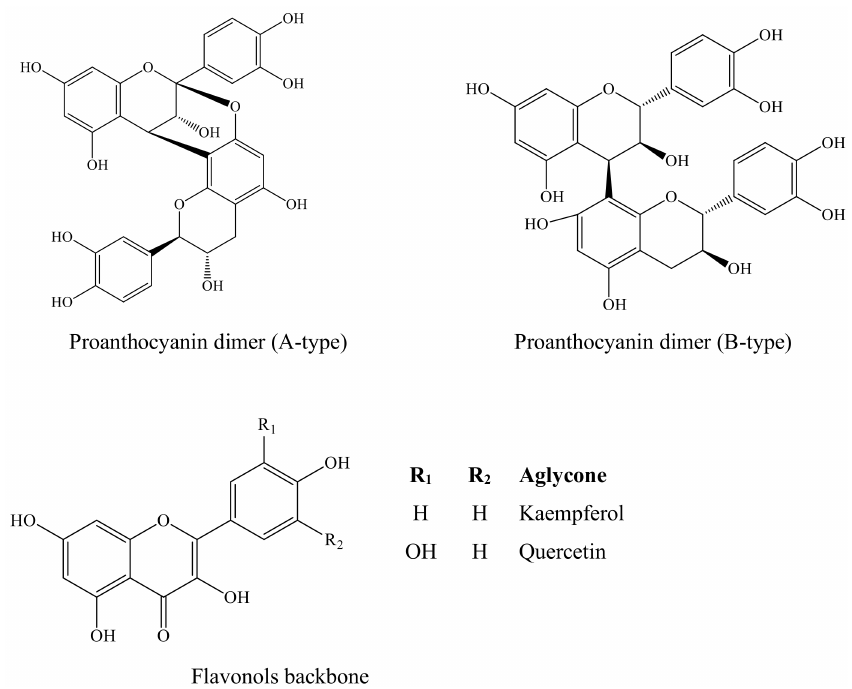
Figure 1. Structure of proanthocyanin dimers (A- and B-type linkages) and main flavonoids deter- mined in the analysed Lauraceae